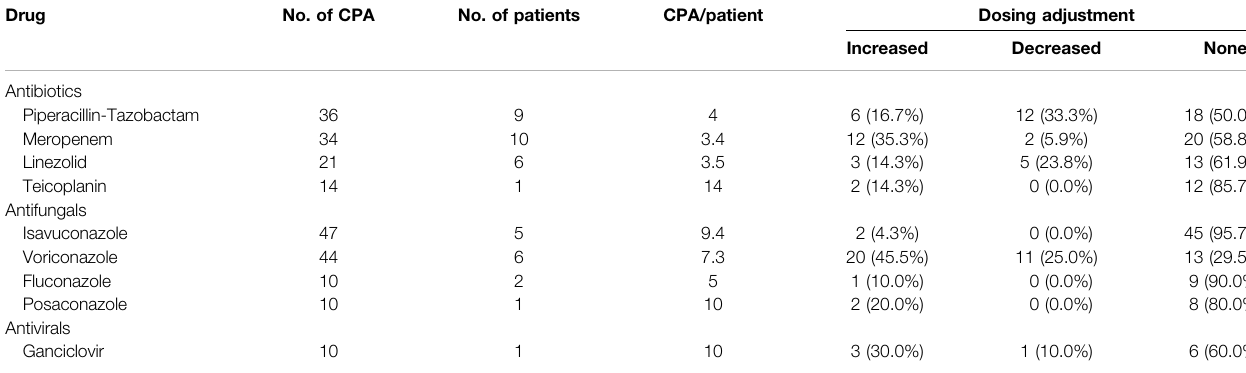
TABLE 4 | Antimicrobials with ≥ 10 CPAs delivered in the study period and the proportion of recommended dosing adjustments. Drug No. of